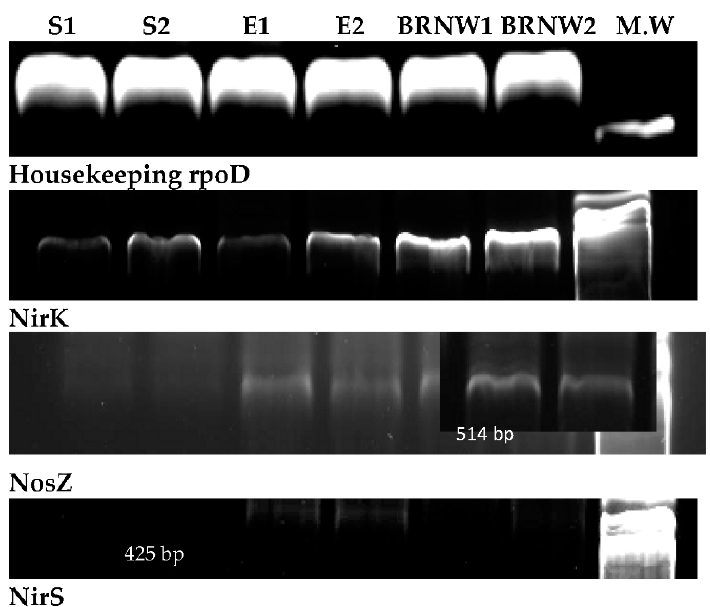
Figure 15. Amplification via RT-PCR techniques for NirS, NirK, NosZ and the RpoD gene used as housekeeping). S1 and S2 correspond to samples from synthetic medium in the presence of MeOH. E1 and 2 correspond to samples obtained from effluents, and BRNW 1 and 2 correspond to samples obtained from culture. The band weights were expressed in base pairs (bp).